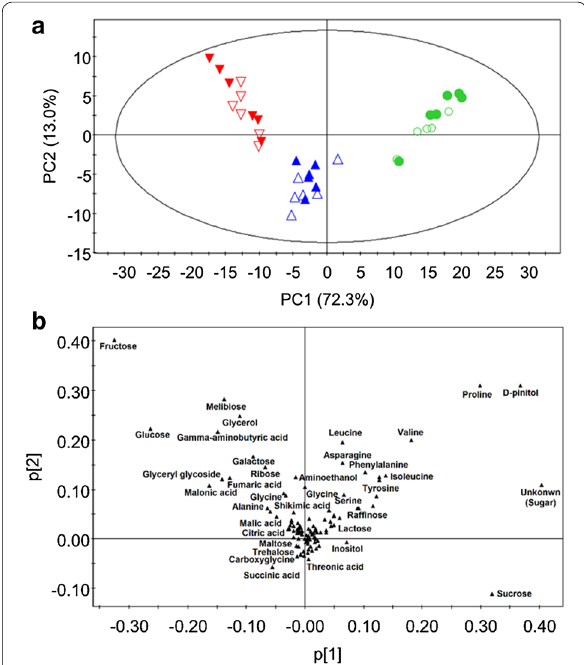
Fig. 2 PCA derived from GC–MS data for drought‑tolerant transgenic soybean ’ABF3’ (filled symbols) and ‘Kwangan’ WT (open symbols) grown under non‑drought (blue open triangle, blue filled triangle), mild‑drought (red inverted open triangle, red inverted filled triangle), and moderate‑drought (green open circle, green filled circle) conditions. a Score plot (ellipse represents Hotelling T 2 with 95% confidence) and b loading